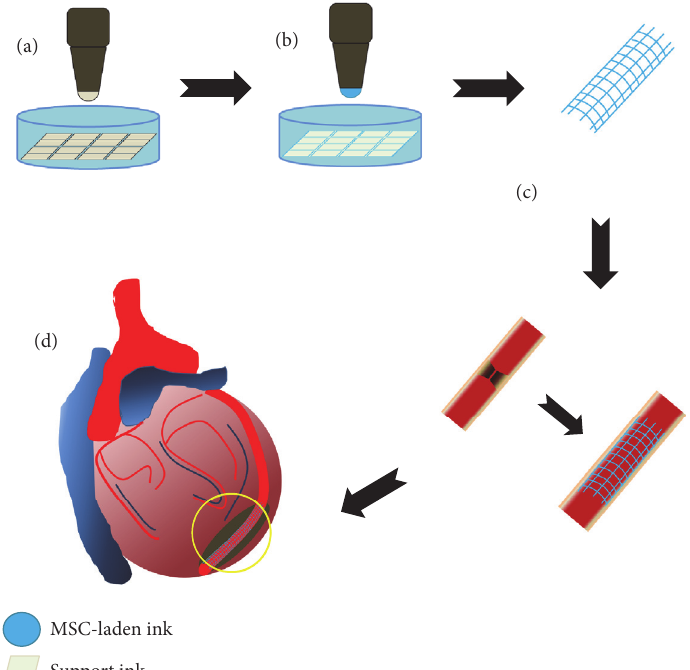
Figure 2: 3D printing-based tissue engineering for myocardiac infarction. (a) Casting a support frame with support ink. (b) MSC-laden ink is cast over the support ink. (c)-(d) 3D printing-based engineered tissues could be used for myocardiac infarction